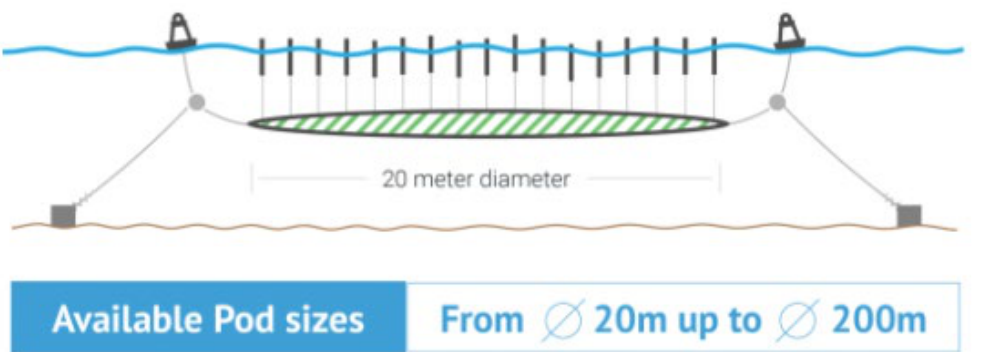
Figure 9. Circular modular systems— Seatech Energy (https://seatechinnovation.com/seaweed-